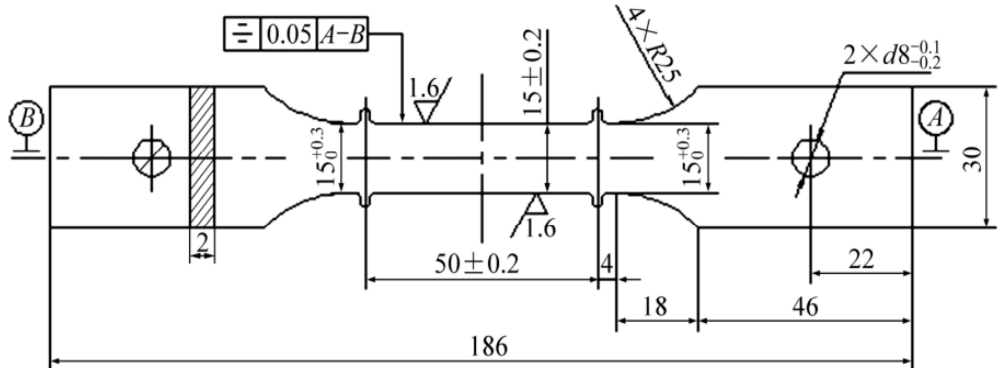
Figure 1. Creep specimen dimension (unit: mm). A and B: datum plane.